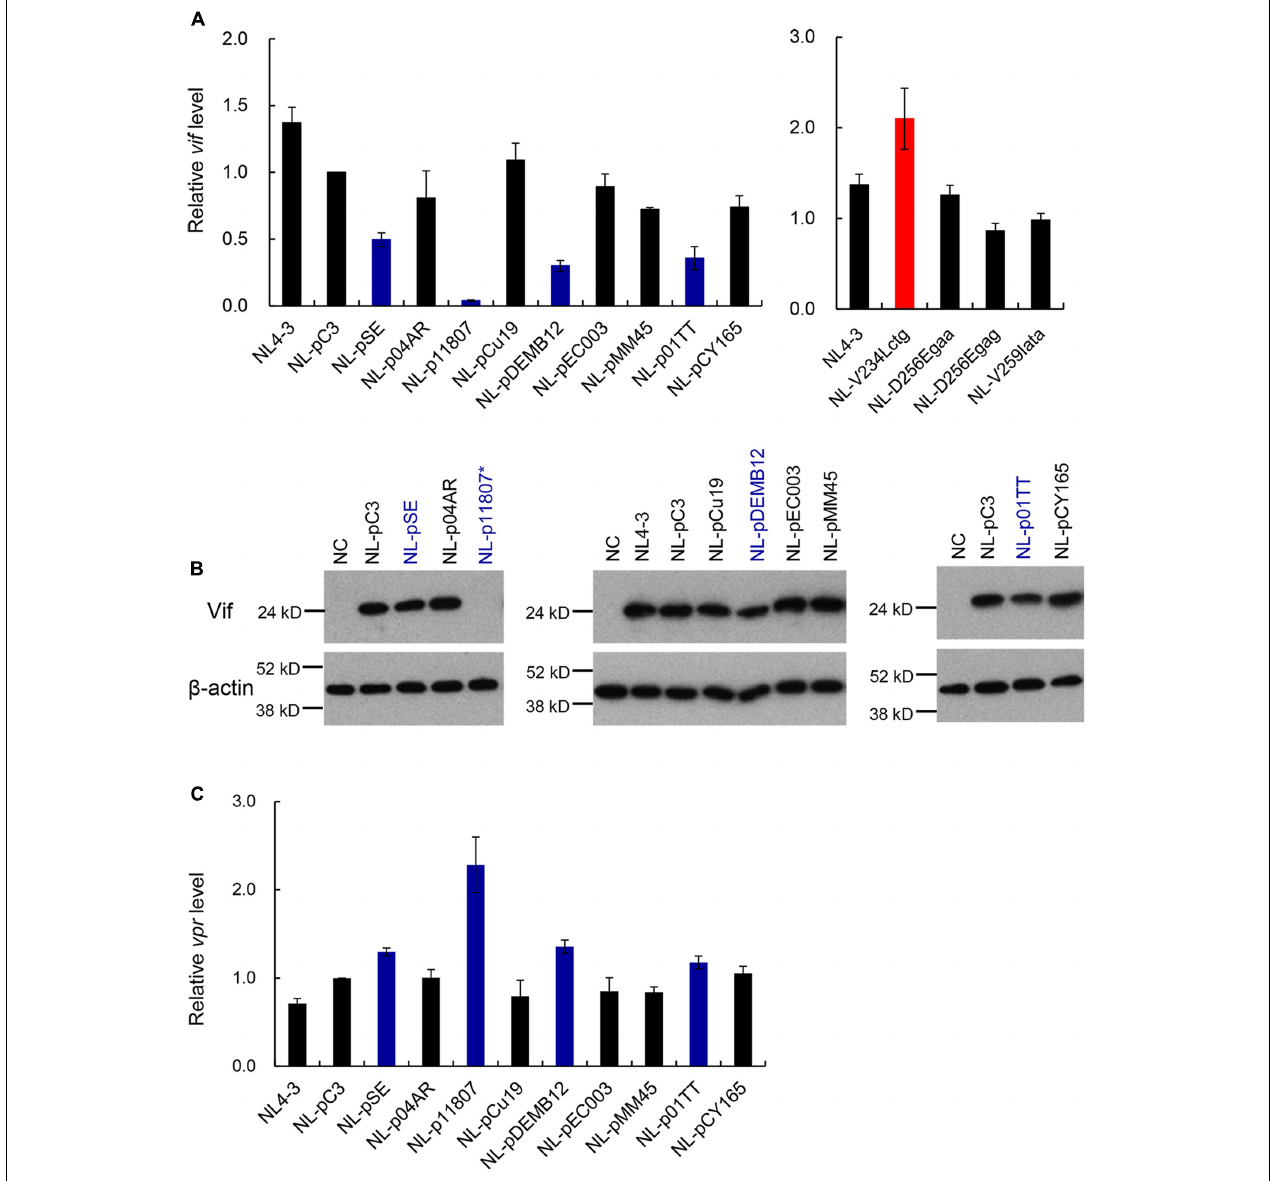
FIGURE 12 | Characterization of proviral clones with a naturally occurring full-length SA1D2prox sequence. Various proviral clones were examined for vif mRNA production, Vif expression, and vpr mRNA production. (A) Expression levels of vif mRNAs by various variants. Proviral clones indicated were transfected into 293T cells, and at 20 h post-transfection, cells were collected for extraction of total RNA. DNase I-treated total RNAs were used to synthesize cDNAs with oligo (dT) primer, and the cDNA samples were subjected to qRT-PCR analysis using a specific primer set of vif mRNA. Expression levels of all HIV-1 mRNA species and GAPDH mRNA were analyzed by qRT-PCR in parallel for transfection and internal controls, respectively. A vif expression level in each sample was normalized by those of all HIV-1 mRNA species and GAPDH mRNA. Vif expression levels relative to that by NL-pC3 are presented. Blue and red bars indicate clones that exhibit lower and higher vif expression levels, respectively, relative to that by NL-pC3. Mean values ± SD from three independent experiments are shown. All clones were simultaneously assayed for vif production, but results obtained are separately shown for clarity. (B) Expression of Vif proteins by various variants. 293T cells were transfected with proviral clones indicated. On day 1 post-transfection, cell lysates were prepared, and analyzed by Western blotting using anti-Vif and anti- β -actin antibodies. Migration positions of mass standards are shown on the left. Representative data from at least two independent experiments are shown. Blue letters indicate clones that exhibit lower vif expression level relative to that by NL-pC3. NL-p11807 ∗ , undetectable. (C) Expression levels of vpr3 mRNA by various variants. Semiquantitative PCR was carried out using cDNA samples prepared as described in (A) and a specific primer set for vpr mRNAs. Expression levels of all HIV-1 mRNA species and GAPDH mRNA were analyzed by semiquantitative PCR in parallel for transfection and internal controls, respectively. Signal intensities of semiquantitative RT-PCR products were quantitated by Amersham Imager 600 instrument. Intensity of vpr3 mRNA in each sample was normalized by those of all HIV-1 mRNA species and GAPDH mRNA. Normalized mRNA intensity in each sample relative to that by NL-pC3 is presented. Blue bars show clones with decreased vif expression level relative to NL-pC3. Mean values ± SD from three independent experiments are shown.